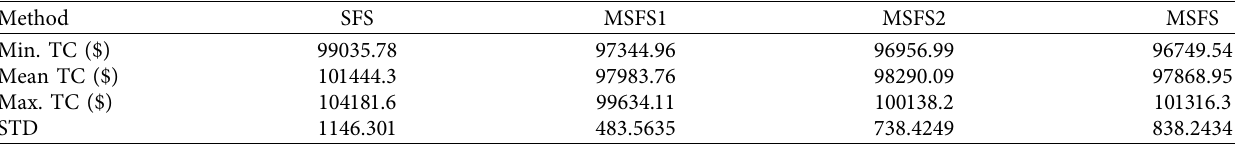
Table 13: Comparisons of result obtained by SFS methods for the 85-bus system with the objective function of total cost. Method